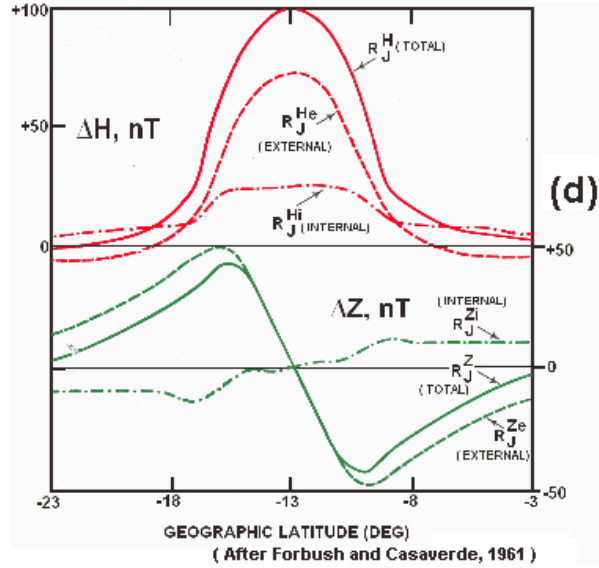
Fig. 2d. Latitudinal profiles of external, internal and total parts of 1H and 1Z for the Peruvian chain of stations during 1GY–1GC (after Forbush and Casaverde,